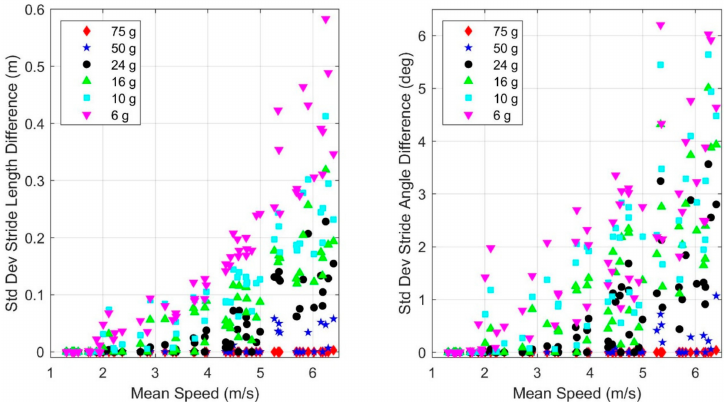
Figure 6. Dependence of the standard deviation of di ff erence in ( a ) stride length and ( b ) stride angle estimates with mean speed and accelerometer range. The di ff erences are computed with respect to the results of the 100 g accelerometer as the